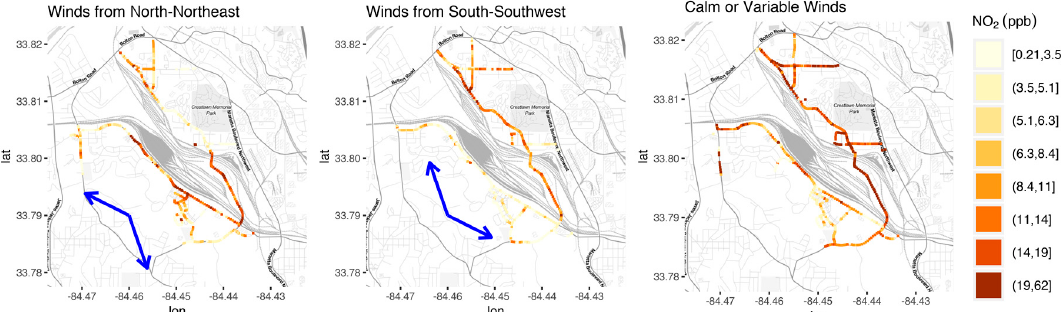
Figure 4. Concentrations of NO 2 aggregated by 50 m road segment during (left) winds from the north-northeast (middle) winds from the south-southwest and (right) calm winds. Segments are binned so that each color represents an equal number of road segments. Blue arrows represent range of mean hourly wind directions.